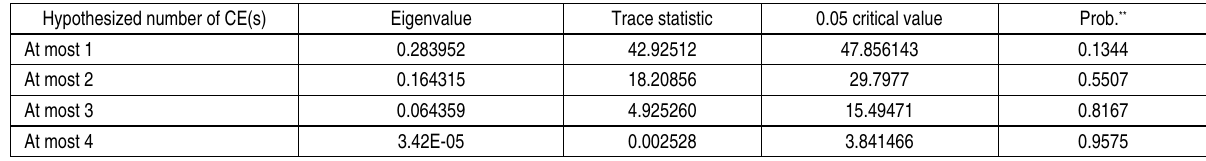
Table 3 (cont.). Unrestricted cointegration rank tests (trace) results